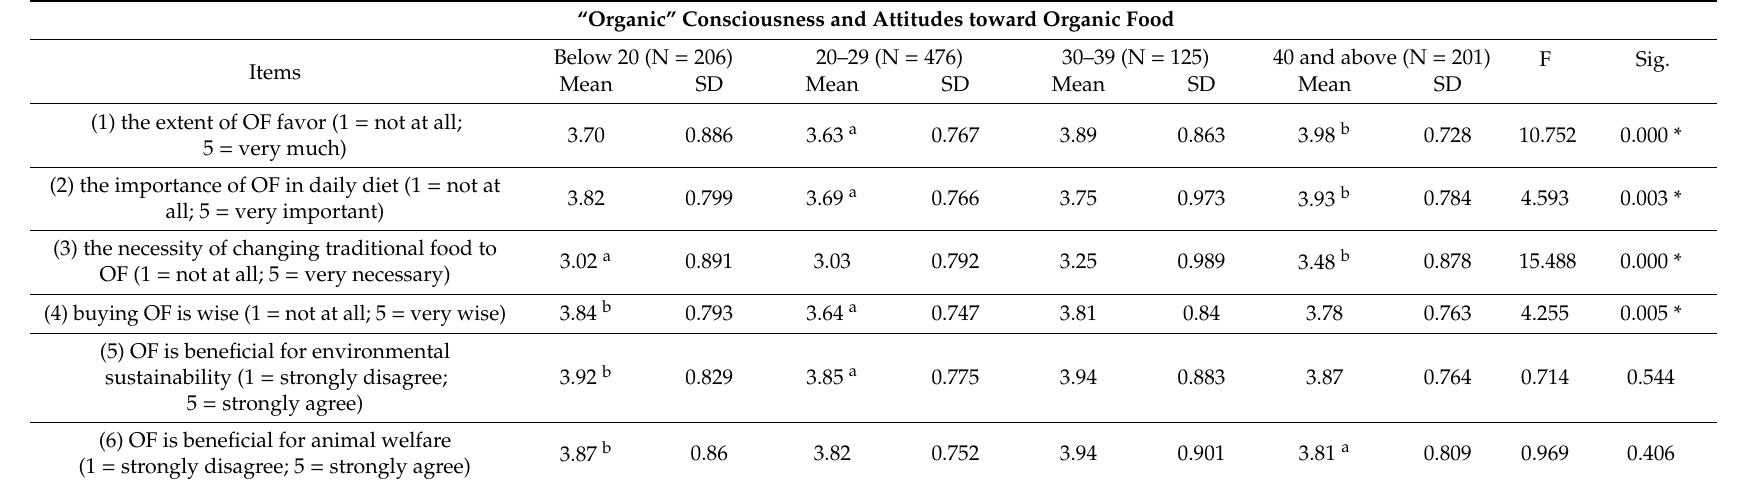
Table 2. The means, standard deviations, and F-tests of di ff erences of the measurement “‘organic’ consciousness and attitudes toward organic food” across age. “Organic” Consciousness and Attitudes toward Organic